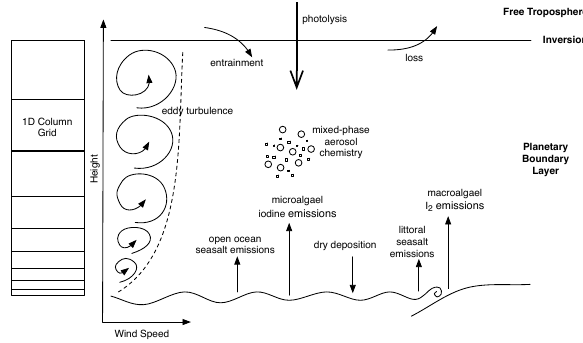
Fig. 1. Schematic of the major processes dealt with in MANIC-1D. An example, non-linear, vertical grid is shown on the